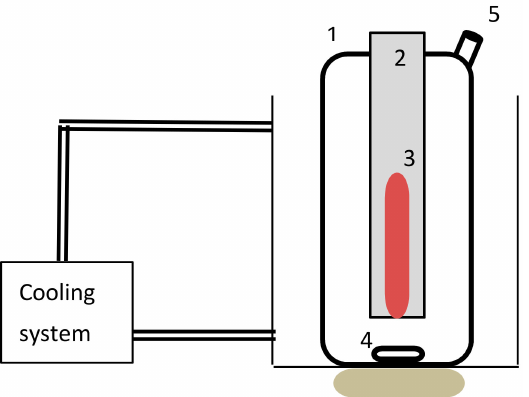
Figure 1. The schematic of the batch UV reactor: (1) reactor vessel, (2) quartz sleeve, (3) UV lamp, (4) magnetic stirrer, (5) sampling